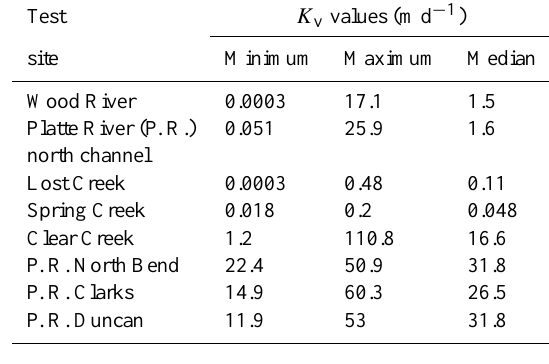
Table 1. Temperatures and EC values collected from five study sites.